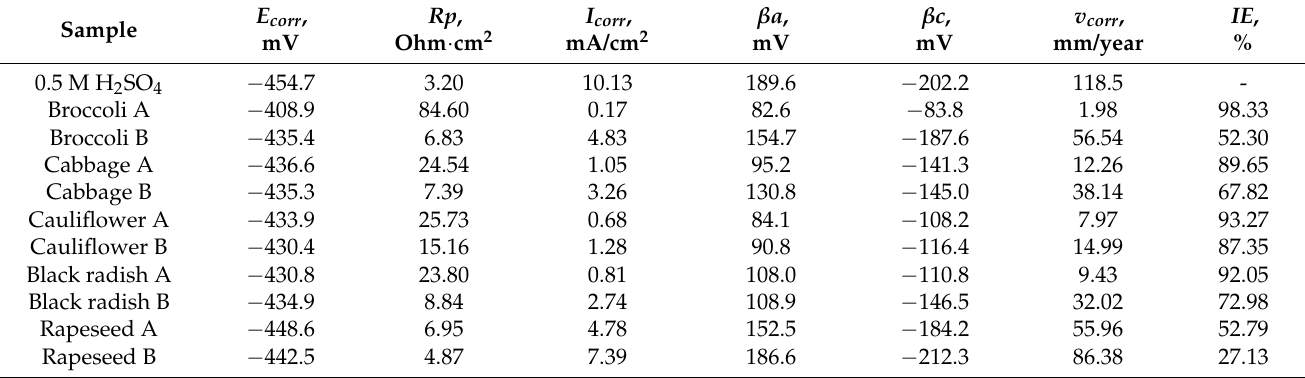
Table 3. Potentiodynamic polarization parameters.